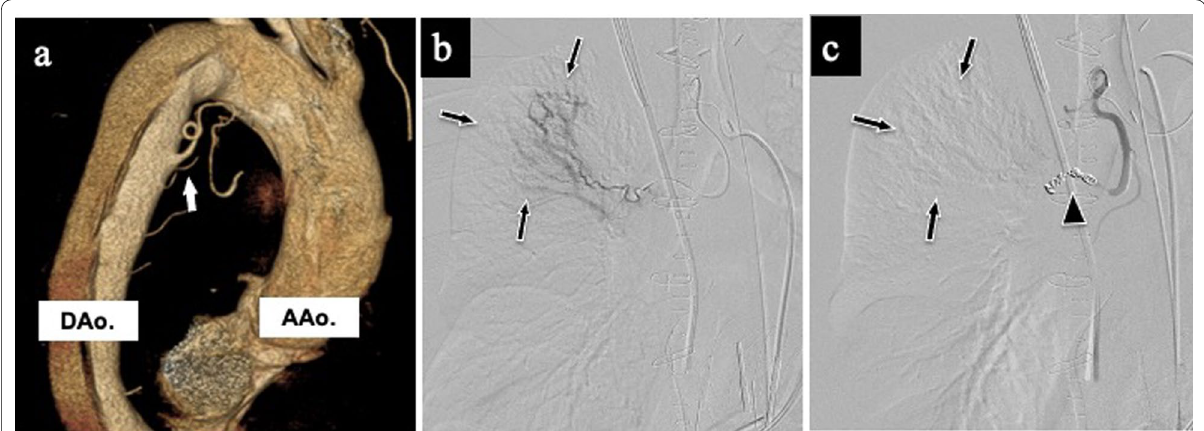
Fig. 1 Preoperative computed tomography and postoperative angiography images in case 1: a BAH identified on preoperative three-dimensional CT image (white arrow); b pulmonary parenchymal blush in the right upper lobe demonstrated on BA angiography (arrows); c disappearance of parenchymal blush (arrows) after embolization (arrowhead) of the BA. BAH bronchial artery hypertrophy, CT computed tomography, BA bronchial artery, AAo ascending aorta, DAo descending